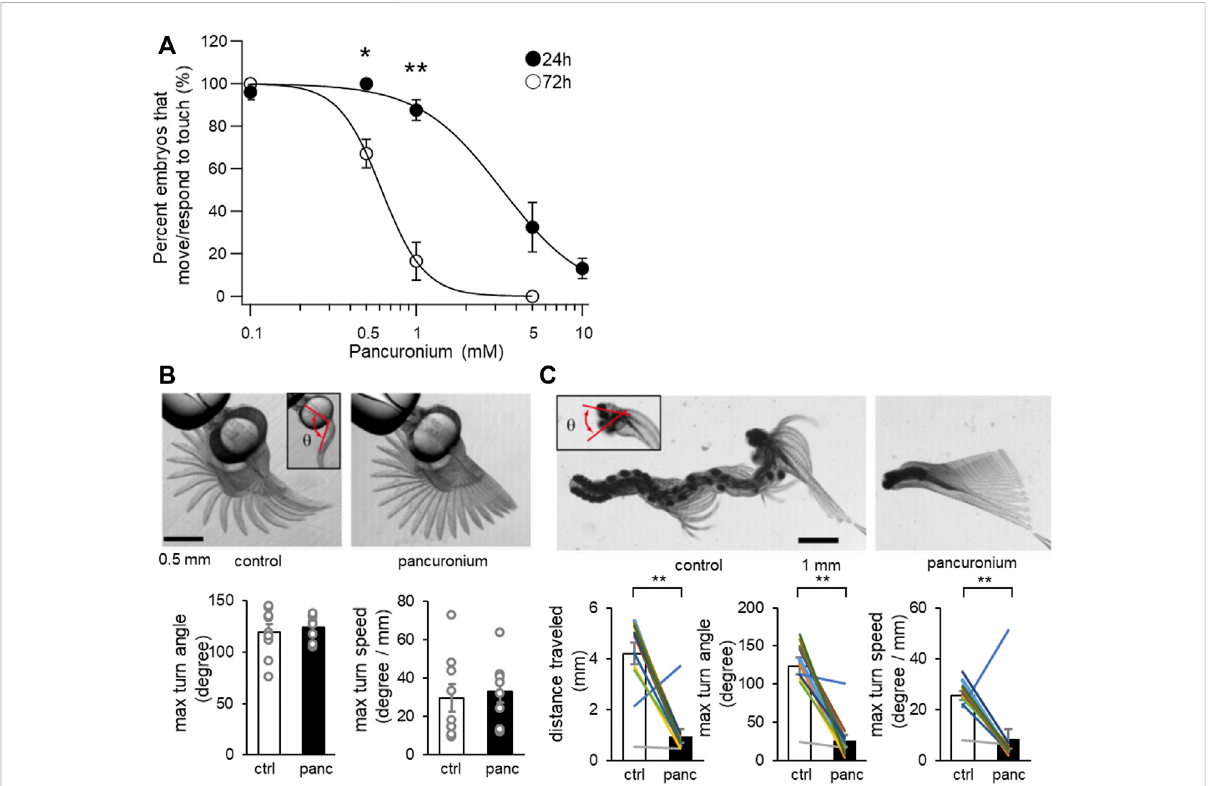
The effect of pancuronium on locomotor activity of zebra fi sh larvae. (A) Concentration dependent effects of pancuronium on locomotor activity of zebra fi sh larvae at 24 and 72 hpf. (* p < 0.05, ** p < 0.01, Student ’ s t -test with bonferroni correction). (B) Superimposed images of spontaneous coiling at 24 hpf (left, control; right, 0.5 mM pancuronium). An inset represents the head-tail angle ( θ ). Max turn angle and max turn speed of spontaneous coiling at 24 hpf are displayed. (Student ’ s t -test). (C) Superimposed images of touch response at 72 hpf (left, control; right, 0.5 mM pancuronium). Aninset representsthehead-turnangle ( θ ).Traveleddistance, maxturnangle andmax turnspeed oftouch responseat 72 hpf are displayed. (** p < 0.01, paired t